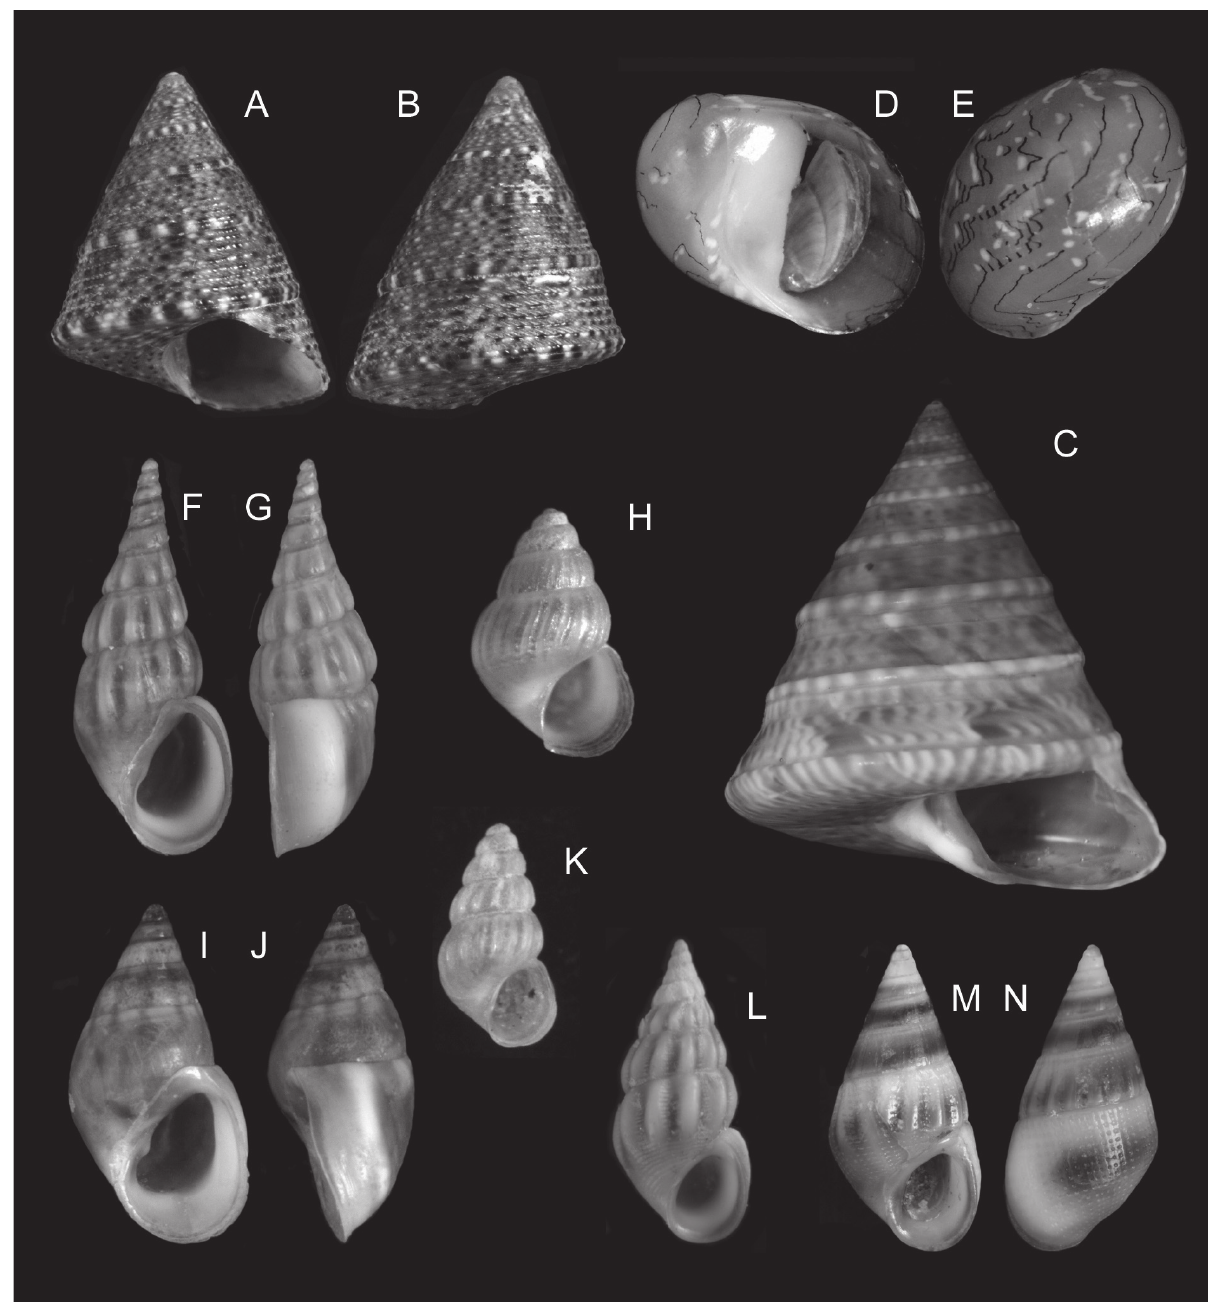
Fig . 2. – Prosobranch gastropods in the leaf stratum of Zostera marina . a, B, apertural and abapertural view of Jujubinus striatus (shell height: 7.1 mm); C, apertural view of Calliostoma planatum (9.9 mm) (also inhabiting the sediment); d, e, apertural and abapertural view of Smaragdia viridis (5.9 mm); f, g, apertural and lateral view of Rissoa membranacea (6.8 mm); H, apertural view of Pusillina inconspicua (3.1 mm); i, J, apertural and lateral view of Rissoa monodonta (4.8 mm); K, apertural view of Pusillina phillippi (2.1 mm); L, apertural view of Rissoa guerinii (4.2 mm); m, n, apertural and abapertural view of Rissoa violacea (4.4